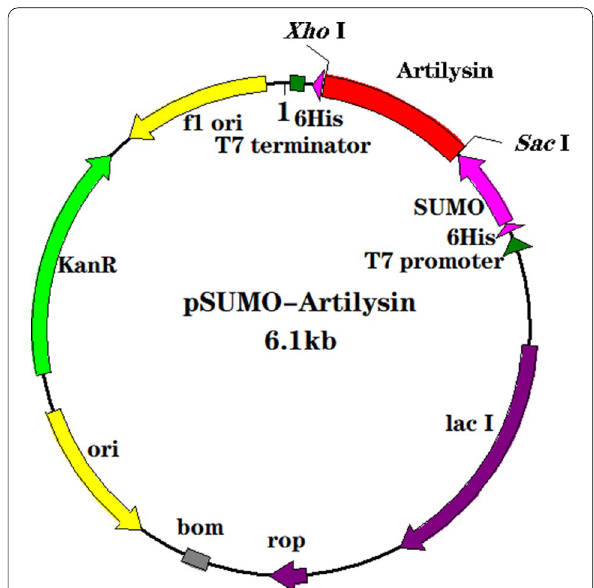
Fig. 2 Recombinant plasmid map. pSUMO-artilysin is a recombinant plasmid designed for expression in E. coli . The red element represents artilysin 1 or 2. The restriction sites are Xho I and Sac